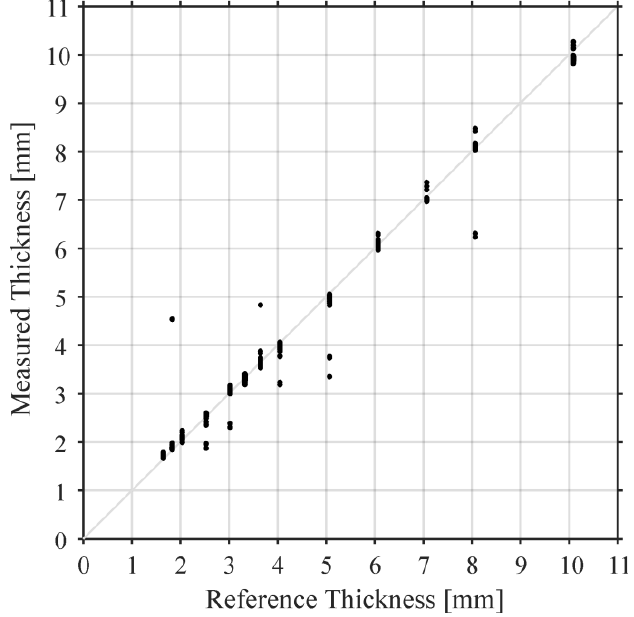
Figure 4. Plate thicknesses obtained by simultaneous measurement of t TR and t ToF using Equation (3). As t TR and t ToF are independent parameters, we can simultaneously estimate longitudinal sound velocity in the sample material (approximately 2800 m/s) using Equation (4), without a reference measurement at a known thickness, which is required for conventional contact ultrasonic measurements. This is only possible because our method is broadband and air coupled. Table 1. Plate thicknesses determined with the presented ultrasound method with reference